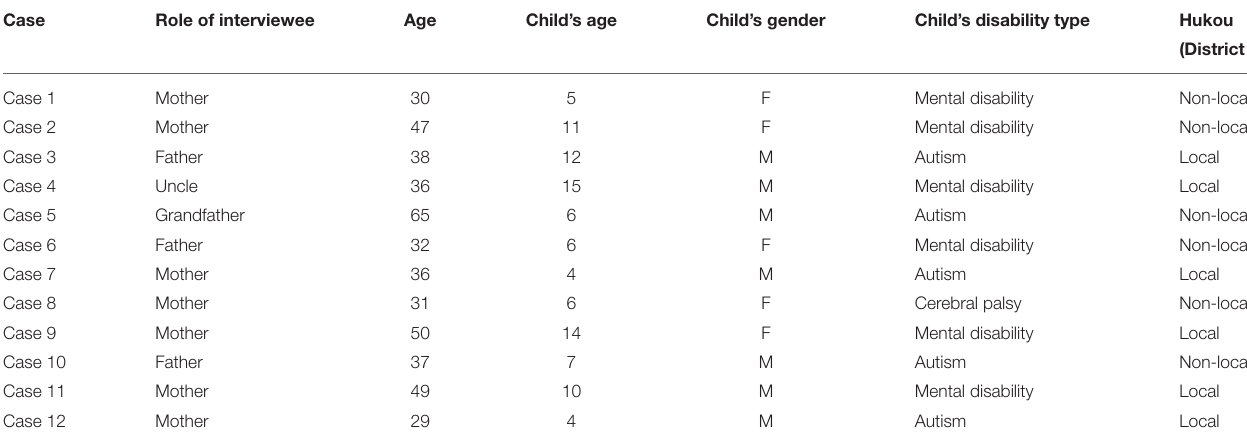
TABLE 1 | Description of research participants – caregivers.